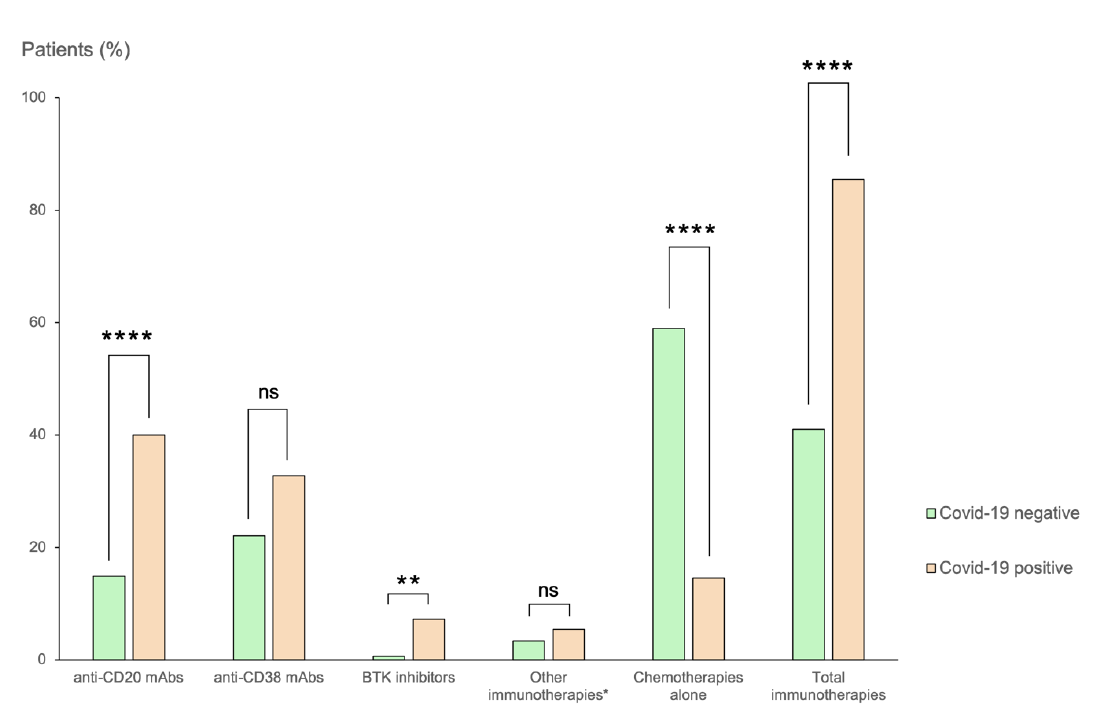
Figure 1. Distribution of hematological treatments (%) in COVID-19-positive and non-positive patients. Abbreviations: mAbs, monoclonal antibodies; BTK, Bruton's tyrosine kinase. (**, p < 10−2 ; ****, p < 10−4 ; ns, non-significant.)